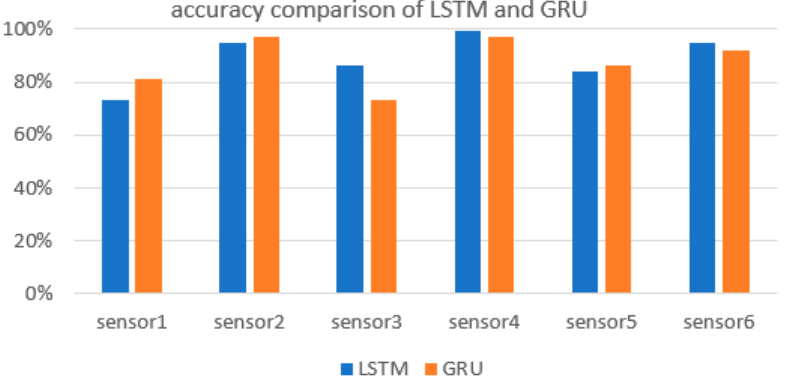
Figure 12. Comparison of accuracy of LSTM and GRU.